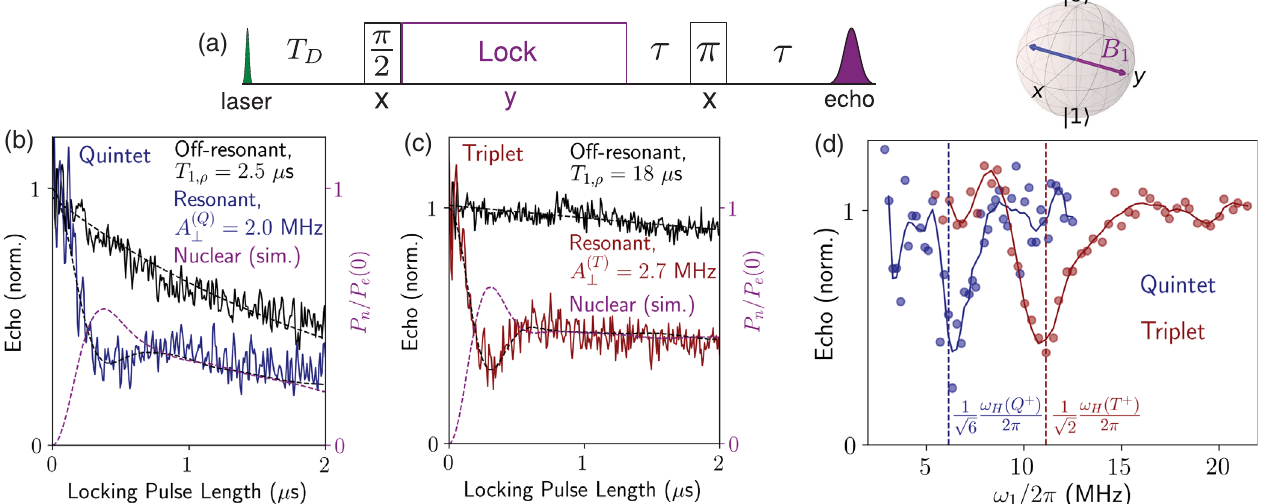
FIG. 6. Selectively coupling quintet and triplet states to site-specific nuclei. (a) Pulse sequence for spin polarization transfer from electronic to nuclear degrees of freedom along with Bloch sphere depiction of spin locking. (b),(c) Pulse-length-dependent polarization transfer from quintet and triplet states to side-chain nuclear spins with simulations for electronic ð P ð 0 Þ the initial electronic spin polarization. (d) Multiplicity selective polarization transfer shown as a shown in dashed lines, with P e function of the microwave driving field ( ω 1 ) for quintet (400 ns locking time) and triplet states (300 ns locking time) measured at the Q þ and T þ transitions,